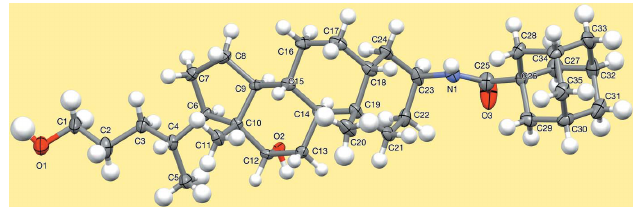
Figure 1 One of the four molecules in the asymmetric unit of the title compound; disordered atoms (N1, O3, C25–C33) and the water molecule are omitted for